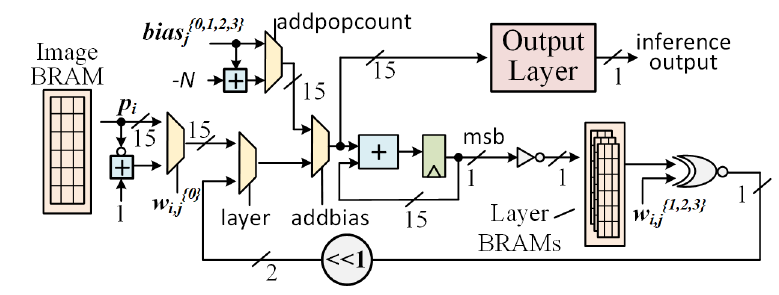
Figure 6: Hardware design of unmasked ModuloNET inference. The design accumulates the partial products in each cycle. It stores the inverted MSBs of the complete summation as the activations. For the output layer, it directly feeds the final summations to the output layer logic that computes the inferred label and its confidence